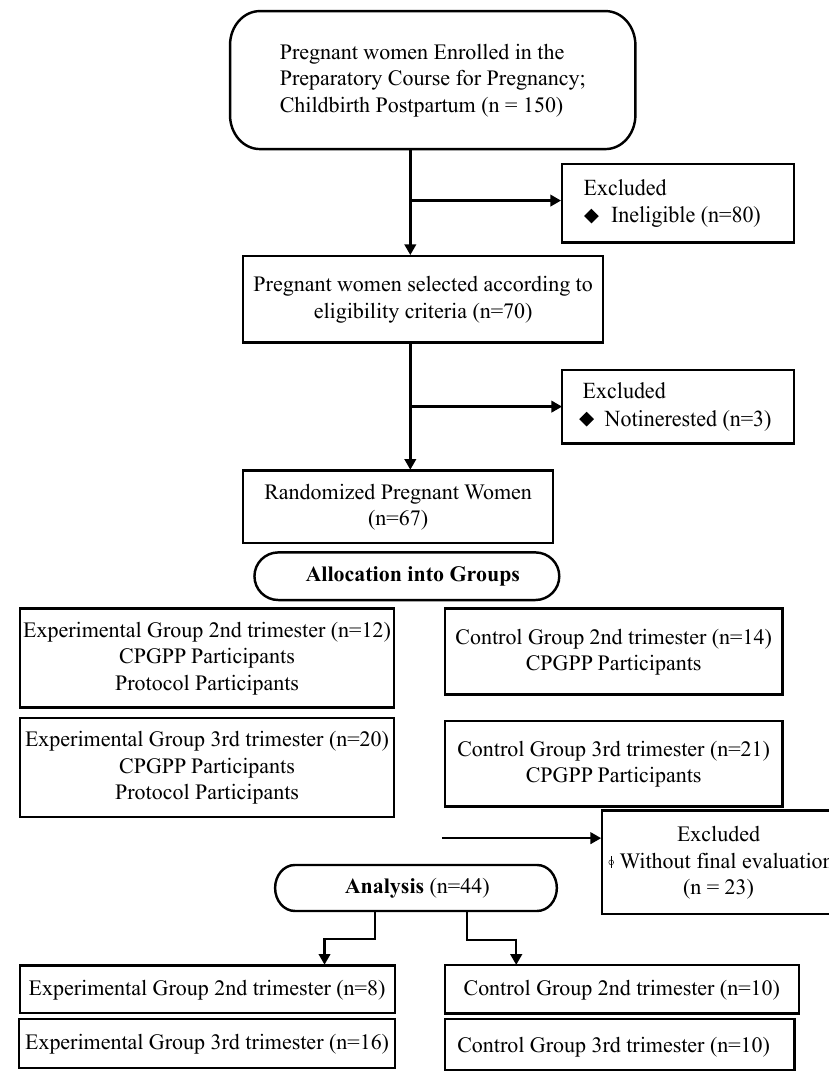
Figure 1. Study distribution flowchart according to